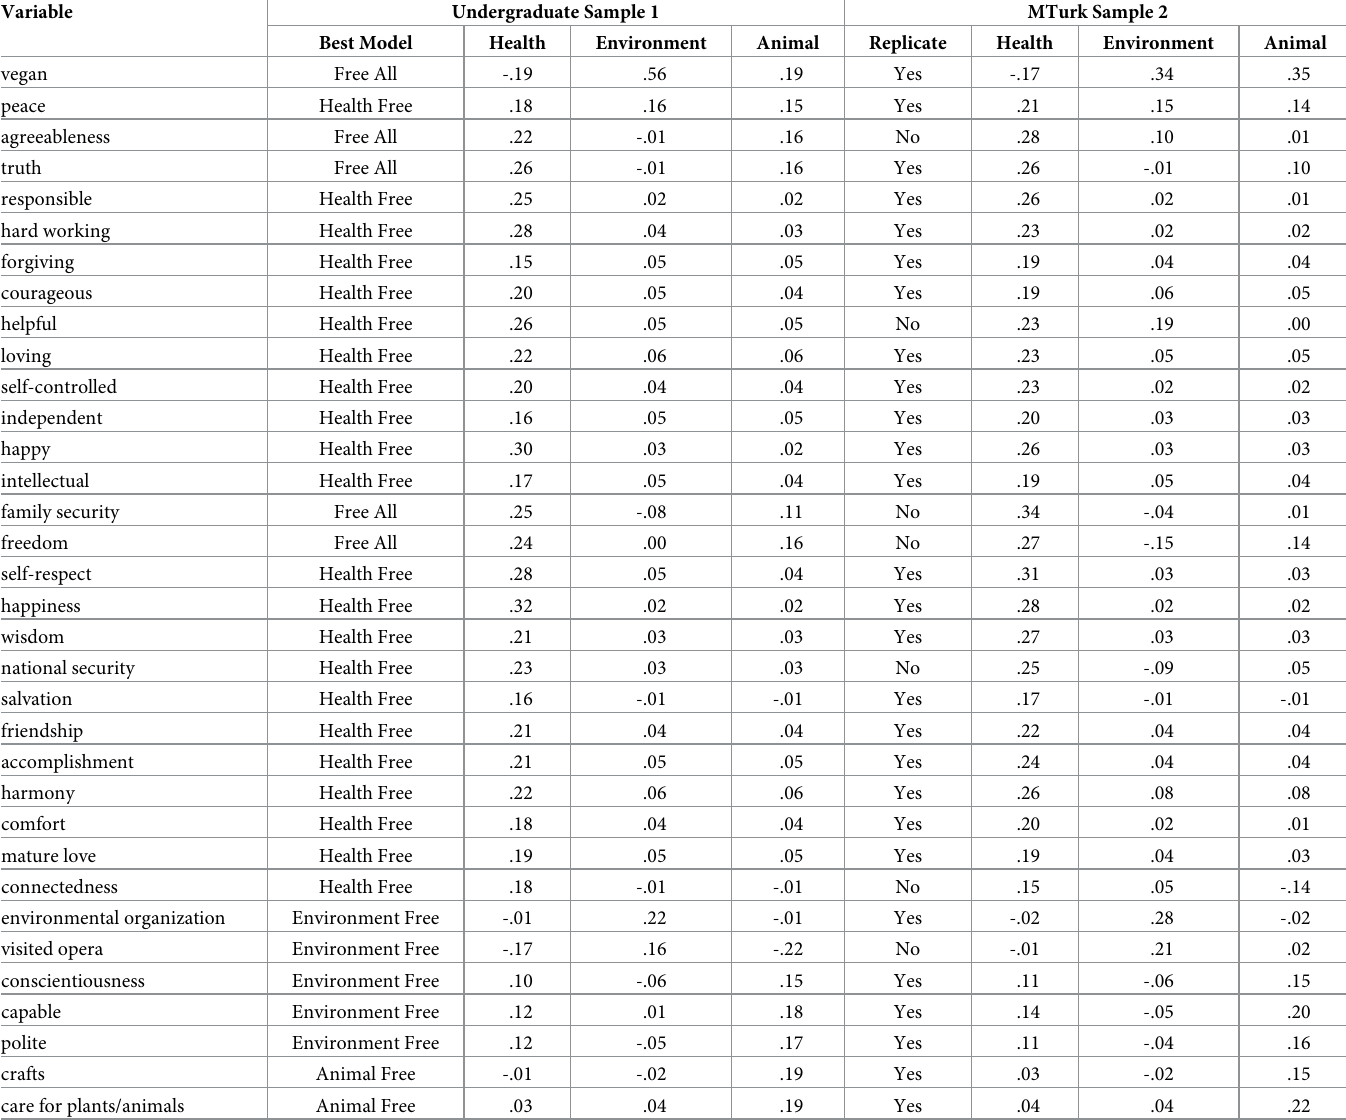
Table 6. Variables with significant associations to plant-based eating motives in two convenience